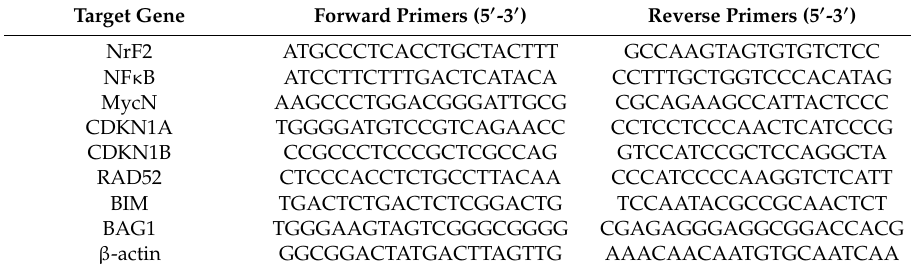
Table 2. qRT-PCR primers for the target